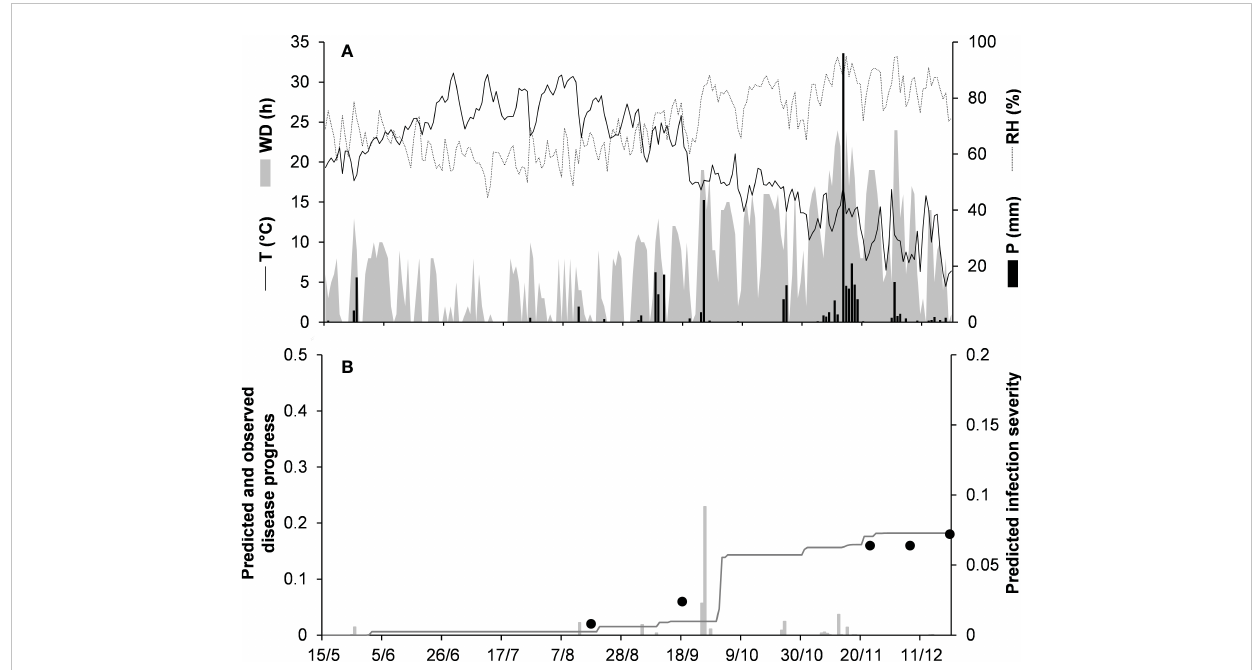
FIGURE 3 Predicted and observed disease progress on olive (susceptible cv. Cellina di Nardo) for the acutatum clade in Veglie, Apulia, Italy, in 2017 (IT-17A). (A) Weather variables: air temperature (T, °C, solid line), relative humidity (RH, %, dotted line), rainfall (P, mm, black bars), and wetness duration (WD, in h, gray area). (B) Infection severity predicted by the model (light gray bars), disease severity predicted by the model (dark gray line), and observed disease incidence (full dots).